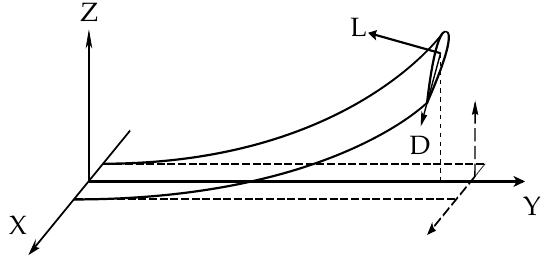
Figure 1. Highly flexible wing showing large deformation and re-orientation of aerodynamic forces.